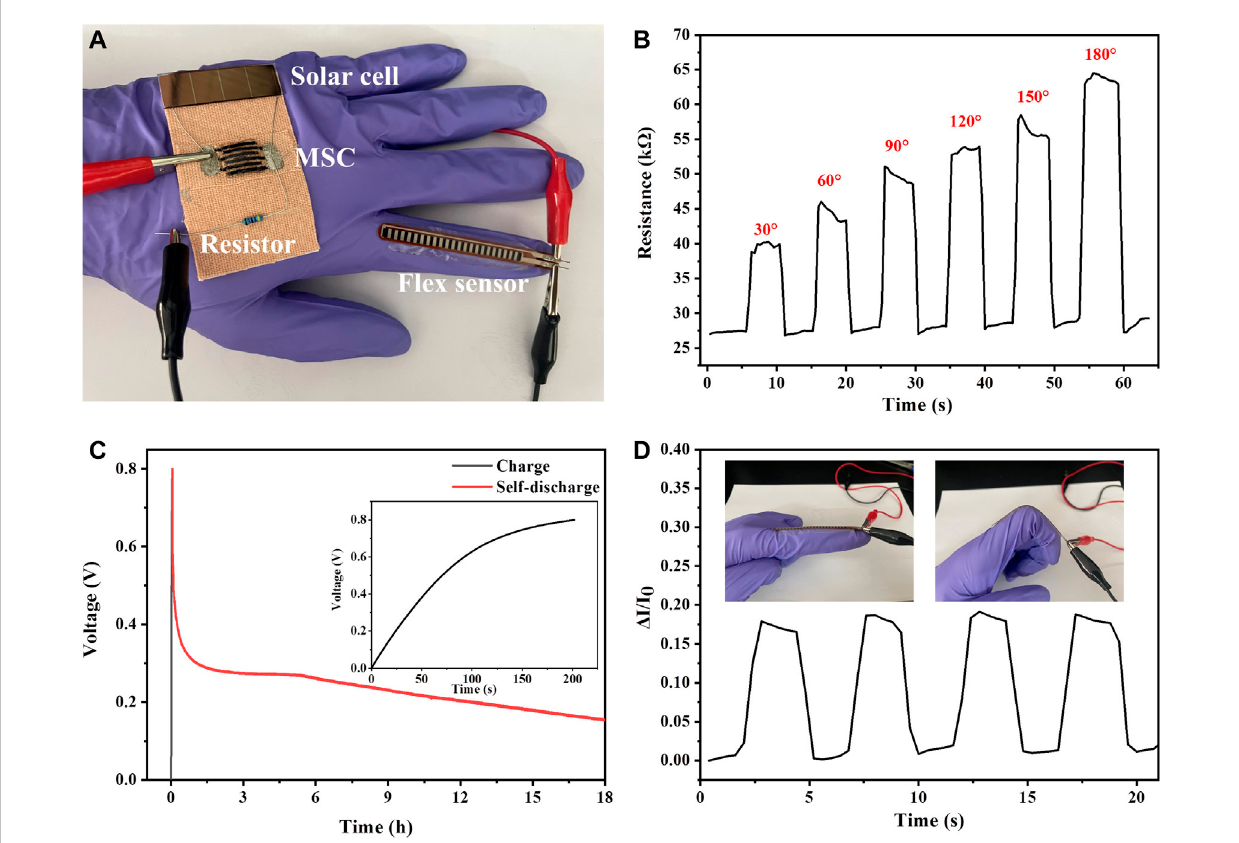
FIGURE 8 (A) Photo of the integrated sensing system. (B) Resistance changes of the fl ex sensor under different bending angles. (C) Charging (by the solar cell) and self-discharging curves of the MSC. The inset shows the enlarged charging curve. (D) Sensing responses for fi nger movements. The insets show the bending states of the fi